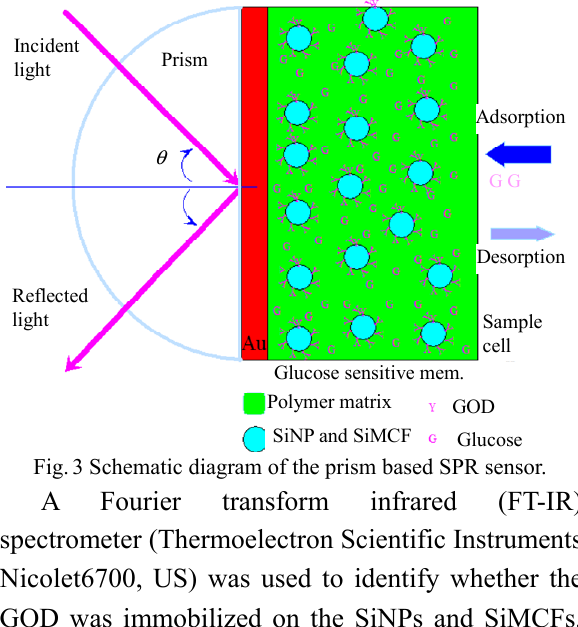
Fig. 3 Schematic diagram of the prism based SPR sensor.